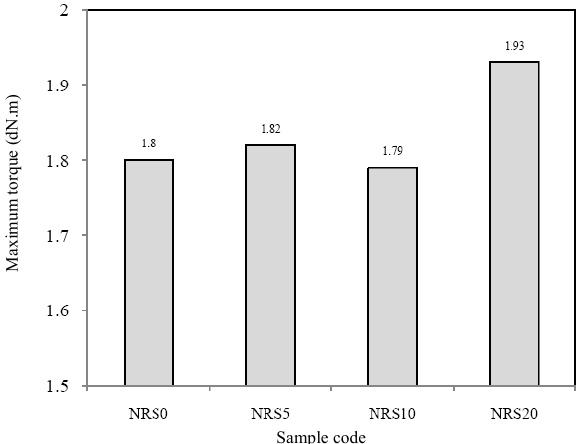
Figure 4. Minimum torque of samples at various silica ratios.